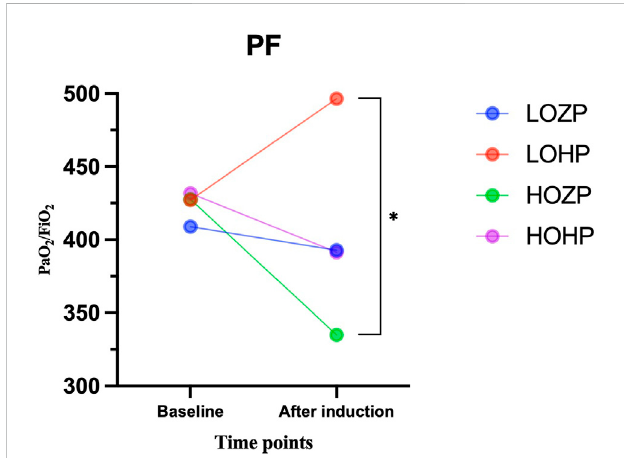
FIGURE 3 ResultsofthePaO 2 /FiO 2 ratiobeforeandafterinductionofthefour groups. The LOHP was signi fi cantly improved ( p < .01), the group LOZP and HOHP remained the same, while the group HOZP signi fi cantly decreased ( p < .01).